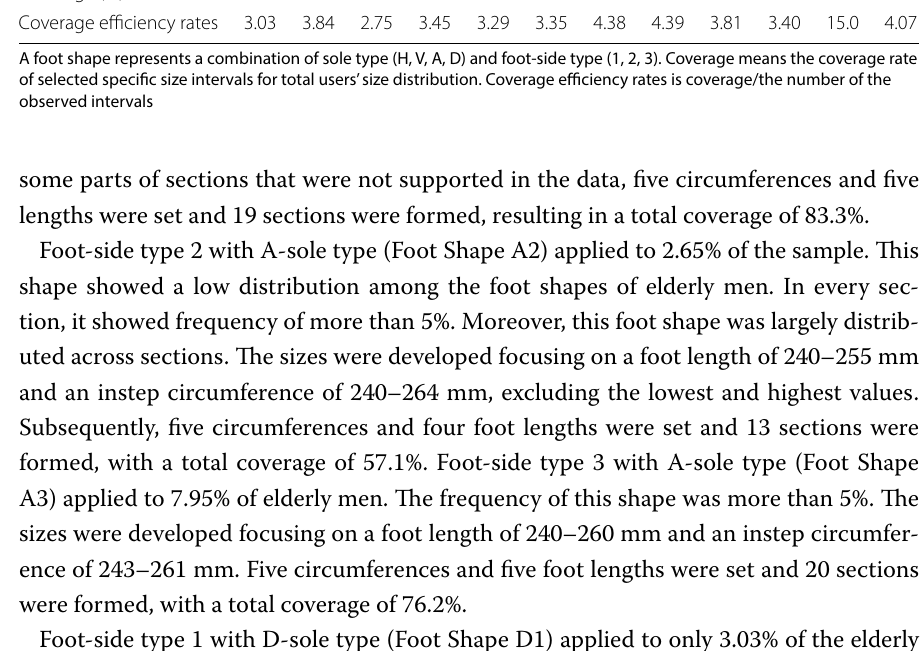
A foot shape represents a combination of sole type (H, V, A, D) and foot-side type (1, 2, 3). Coverage means the coverage rate of selected specific size intervals for total users’ size distribution. Coverage efficiency rates is coverage/the number of the observed